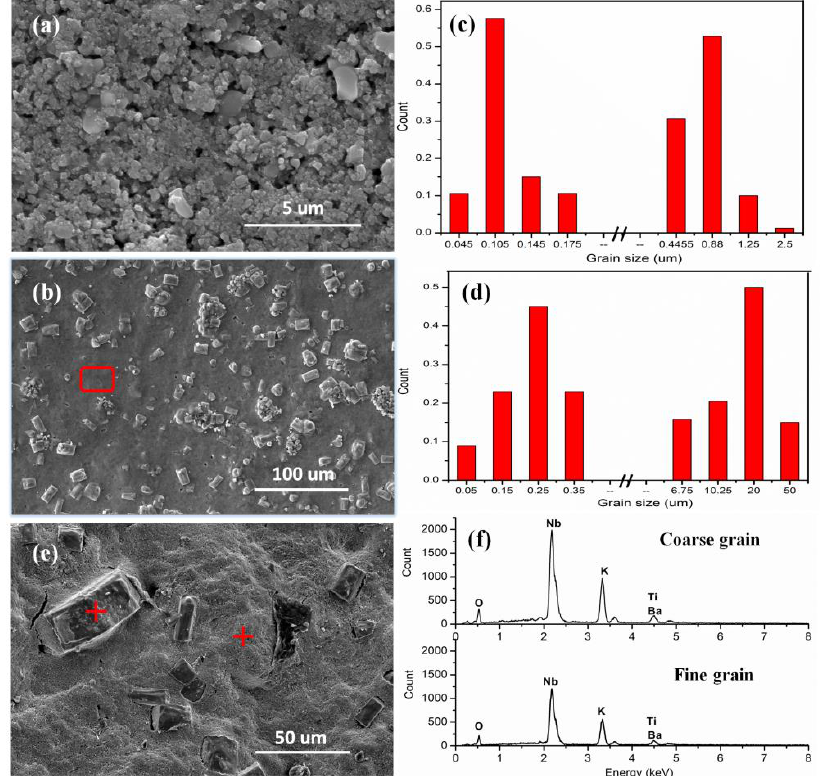
Figure 3. SEM images of the KN-BT(9/1) bulk ceramics sintered at ( a ) 1000 °C and ( b ) 1050 °C, together with ( c , d ) corresponding grain size distribution profiles. ( e ) Cross-sectional SEM image of the KN-BT(9/1) bulk ceramic sintered at 1050 °C, with ( f ) its corresponding EDS results, marks indicating the selected coarse and fine grains.